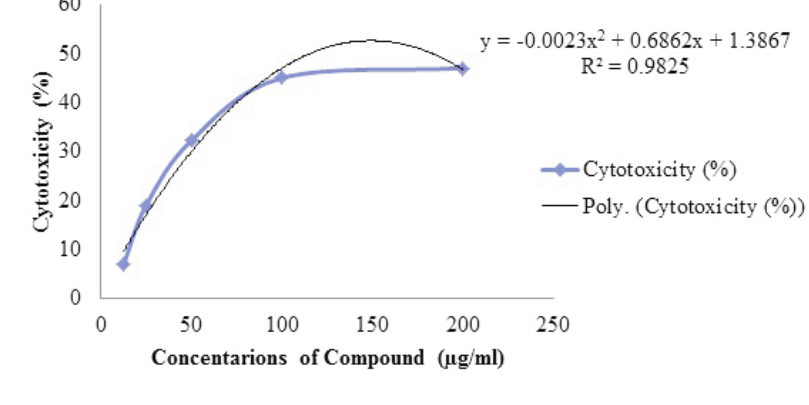
Figure 3. Regression curve of the cytotoxicity of Vero cells after treatment with [Cu(2,4,5-triphenyl-1 H -imidazole) 2 (H 2 O) 2 ].Cl